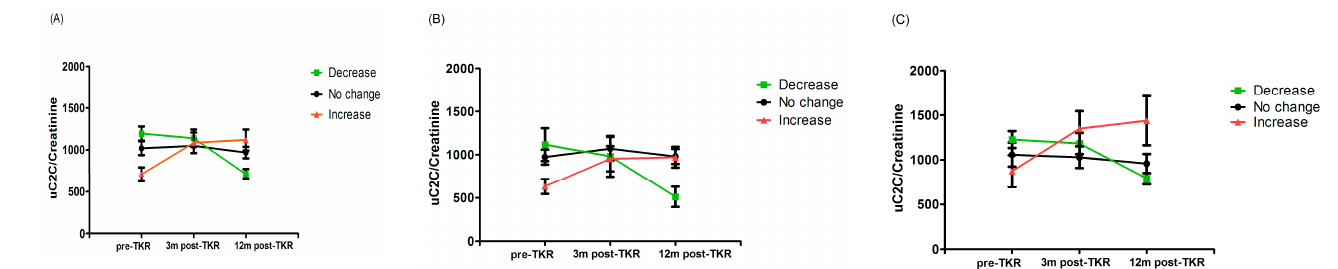
Figure 5. Line plot of uC2C dynamics in ( A ) the whole group, ( B ) males, and ( C ) females, grouped by postoperative uC2C changes (decrease or increase means a > 20% decrease (green) or increase (red) in the 12-month post-TKR uC2C/Crea value compared to the preoperative one; mean and SEM shown).